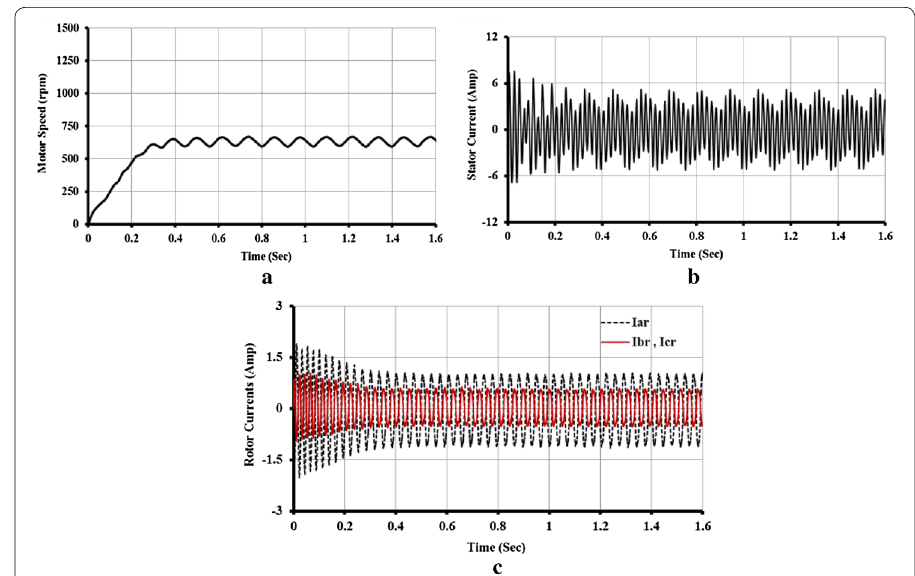
Fig. 9 Experimental results for standard delta connection with external open circuit, a motor speed, b stator phase current and c rotor currents